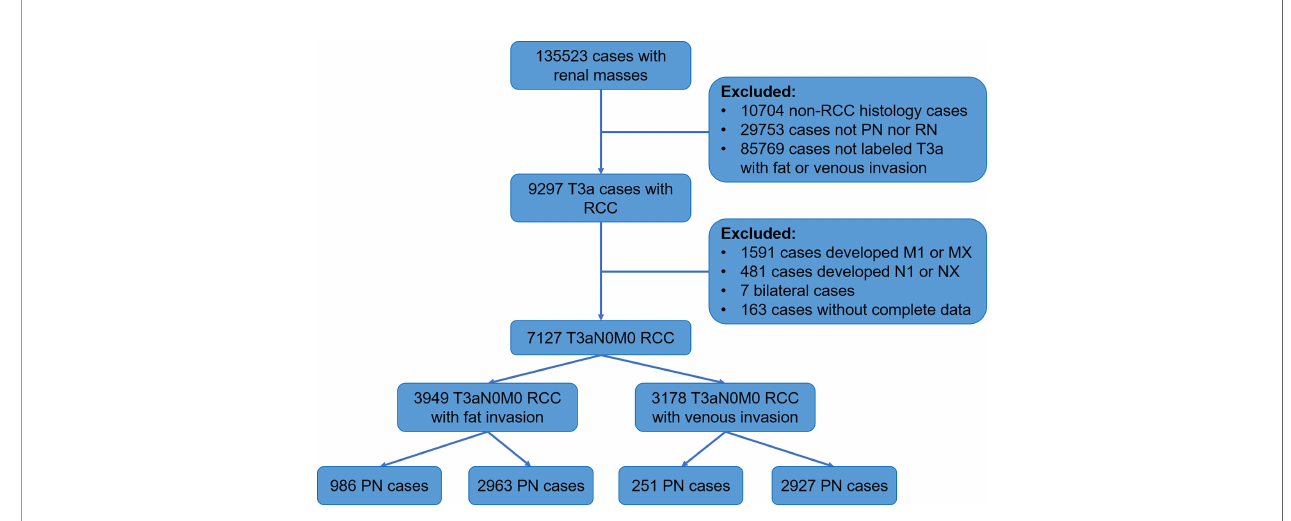
FIGURE 1 | Flowchart displaying patient selection